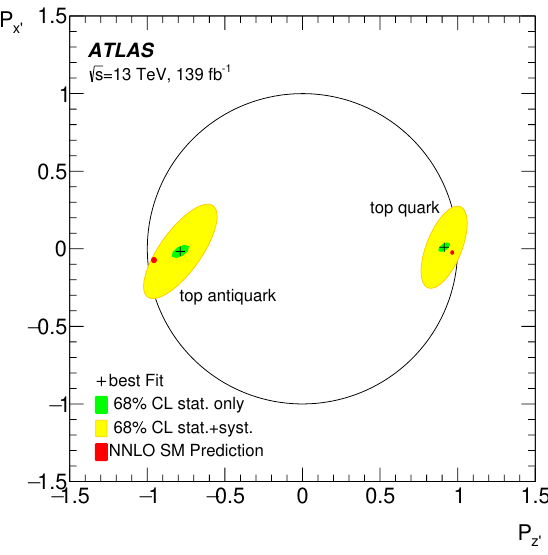
Figure 5 . Summary of the observed best-fit polarisation measurements with their statistical-only (green) and statistical+systematic (yellow) contours at 68% CL, plotted on the two-dimensional polarisation parameter space ( P ). The interior of the black circle represents the physically z 0 , P x 0 allowed region of the parameter space, and the red point indicates the parton-level prediction at NNLO from a calculation based on ref. [8]. The uncertainty in the theoretical prediction includes scale, α and PDF uncertainties. Correlations between the predictions of the polarisation parame- s ters are not